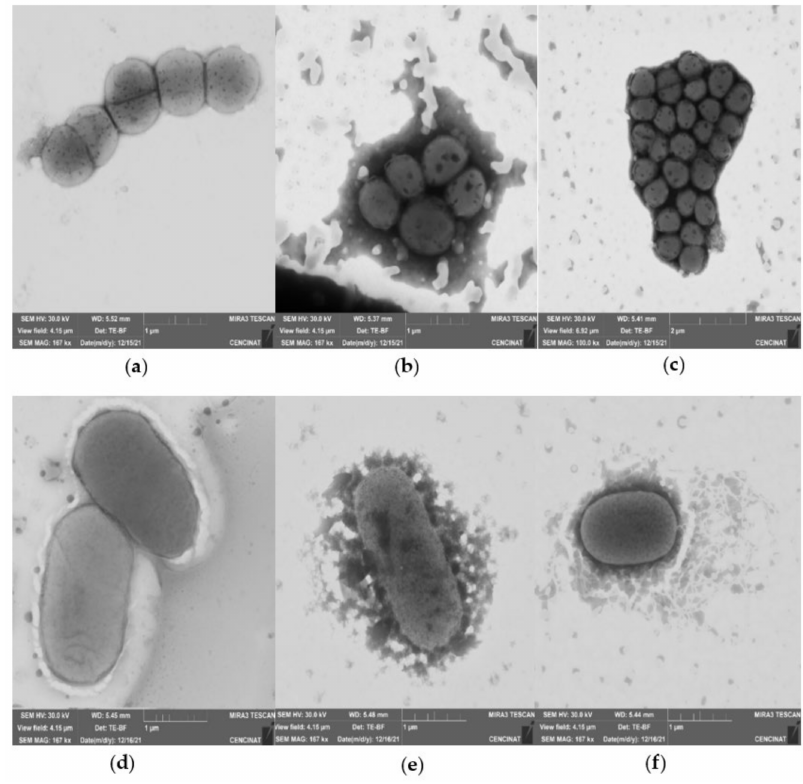
Figure 9. STEM of ( a ) S. aureus ; ( b ) S. aureus + C1 (VCL/PEGDA-MNPs-GO-ZnMintPc); ( c ) S. aureus + C2(VCL/PEGDA-MNPs-MWCNTs-ZnMintPc); ( d ) E. coli ; ( e ) E. coli + C1; ( f ) E. coli +